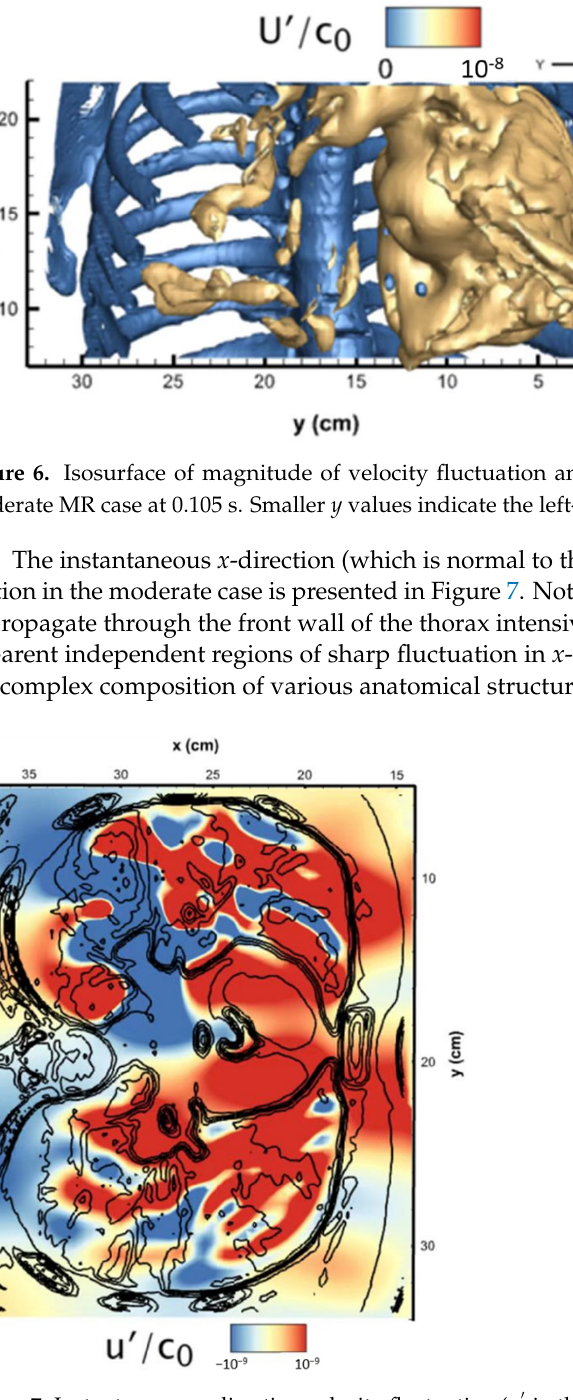
Figure 7. Instantaneous x -direction velocity fluctuation ( 𝑢′ ) in the moderate case at 0.105 s. Black lines are the contours of the density. Smaller y values indicate the left-hand side of the body.